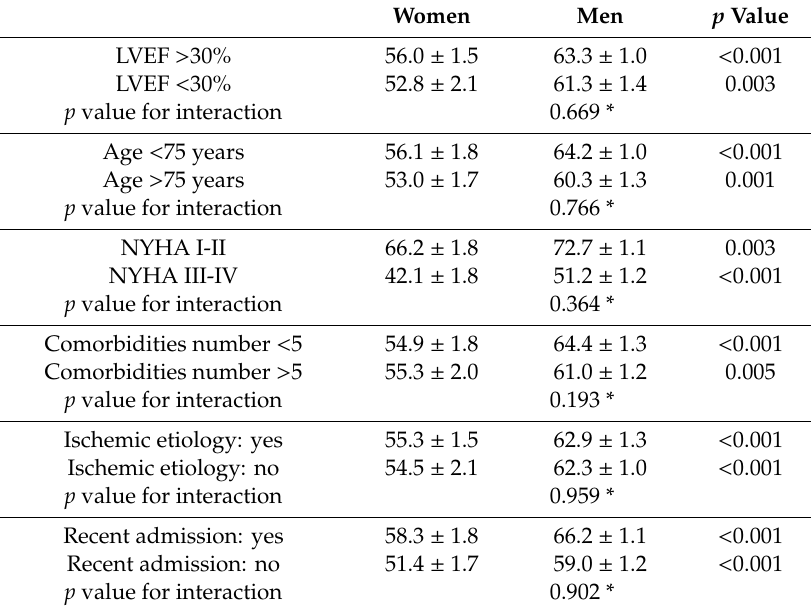
Table 3. General linear multivariate models exploring interaction between gender and other clinical determinants in key variables with prognostic value in HF with reduced ejection fraction patients, over KCCQ global summary